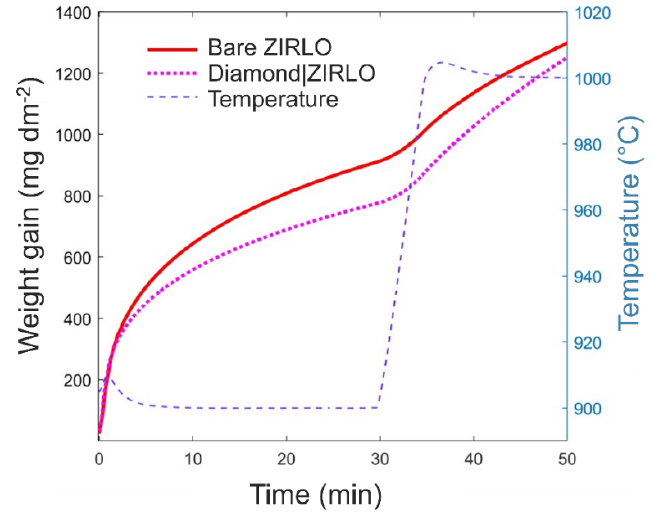
Figure 3. Oxidation kinetics—evolution of the weight gain during the hot steam treatment of bare and coated ZIRLO rods for 30 min at 900 °C followed by 20 min at ~1000 °C. Table 1 . Hot steam treated ZIRLO oxidation. Values of the weight gain (given in % and mg dm − 2 ) for ZIRLO protected by diamond coating and uncoated ZIRLO rods after the exposure to the hot steam treatment. Note: the recalculated (normal- ized) values of weight gains of the coated parts of the samples are given.